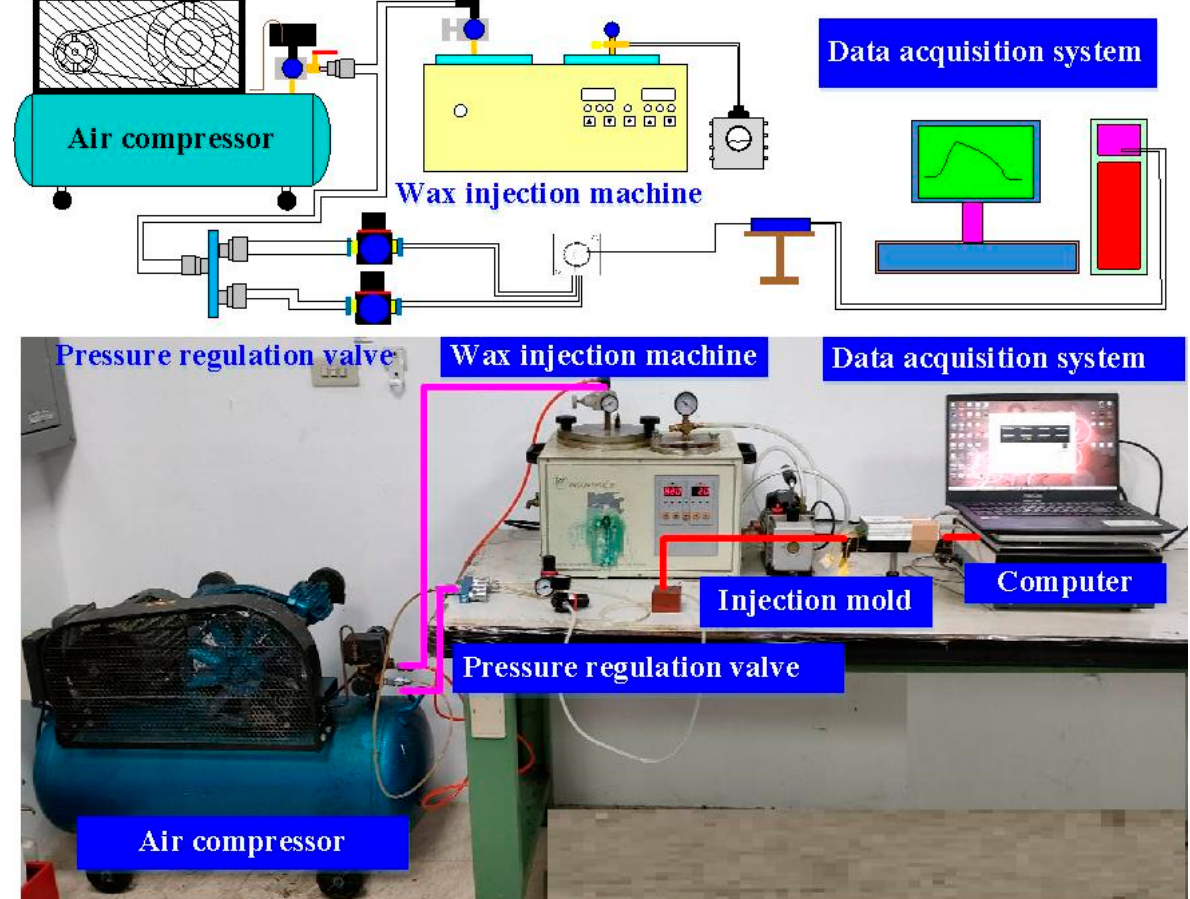
Figure 4. An in-house cooling time measurement system.